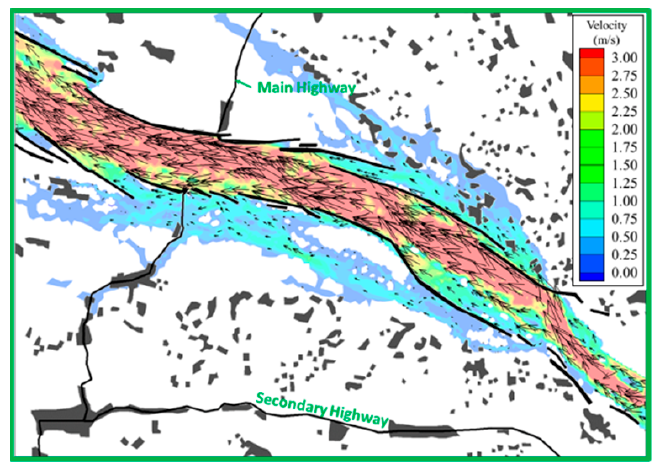
Figure 17. Overflow and return flow through levee openings (Case